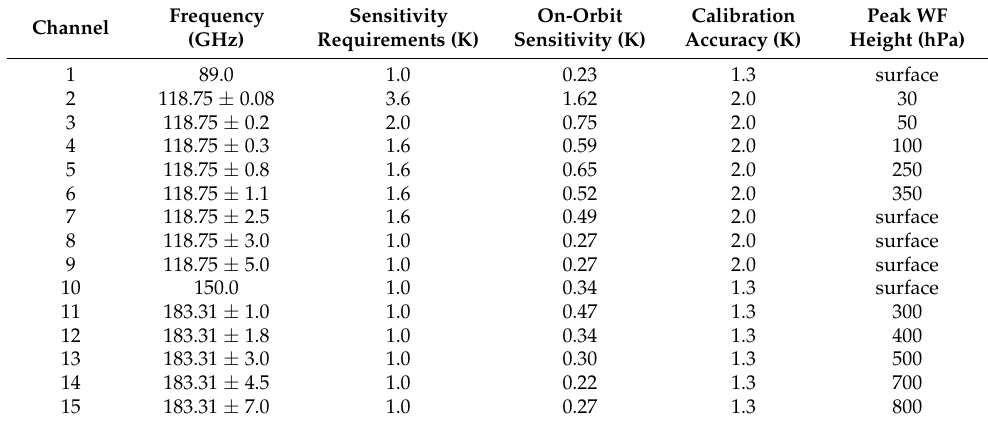
Table 1. Channel characteristics of MWHTS.